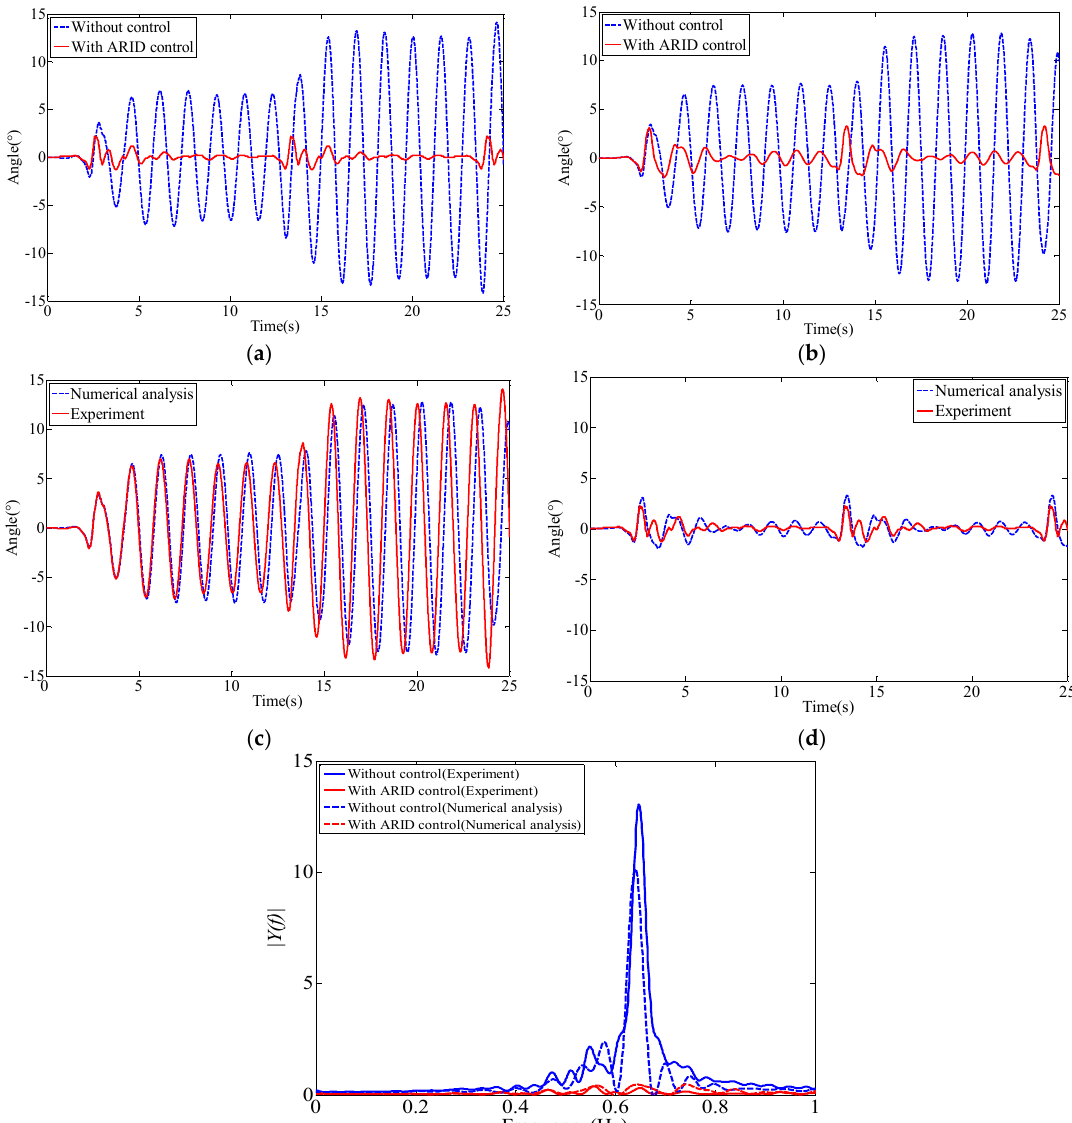
Figure 10. Numerical results of the swing angle of the structure with the TRID or ARID system.